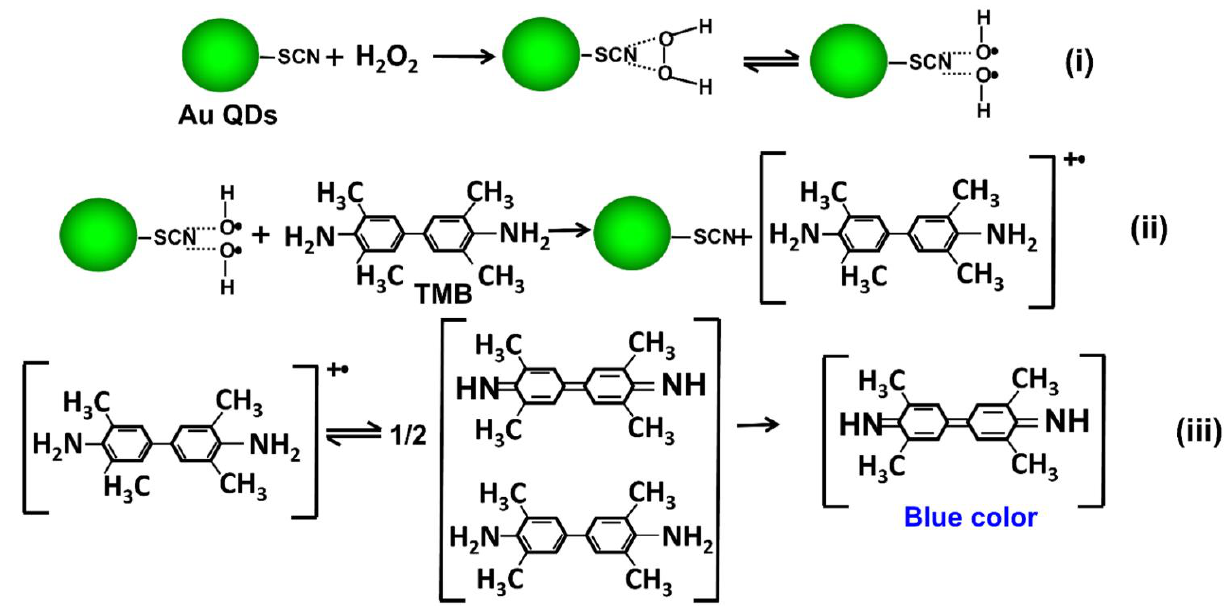
Figure 5. Mechanism study of Au QDs’ enzyme-like nature: ( i ) formation and adsorption of •OH radicals on the surface of Au QDs; ( ii ) oxidation reaction of TMB initiated by •OH radicals and ( iii ) formation of a dimer structure of oxidized TMB molecules that turns the solution color to deep blue.